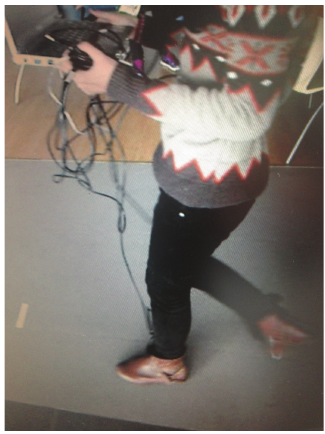
Figure 3: Data acquisition